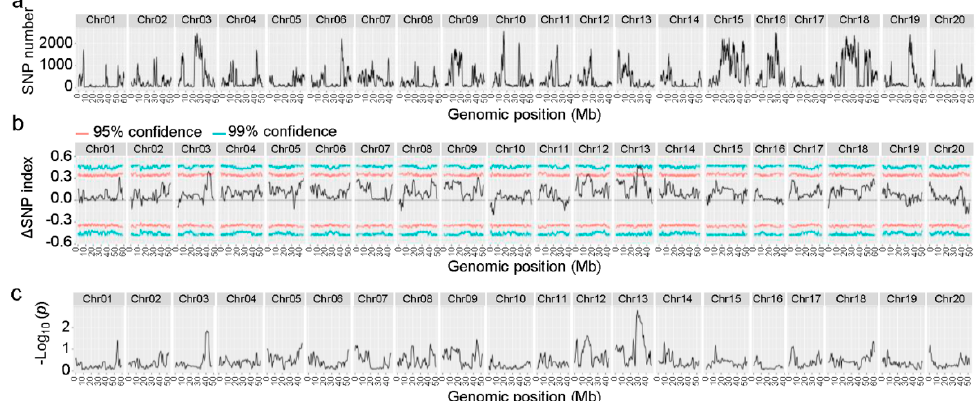
Figure 3. Distribution and plot of SNPs. ( a ) Distribution of all SNPs on twenty soybean chromosomes. ( b ) Δ SNP index graphs from NGS-based BSA. ( c ) Distribution of p value (presented as -log 10 ). X-axis represents the position of twenty chromosomes and Y-axis represents the number of SNPs ( a ), ∆ SNP index ( b ), or p value ( c ). Δ SNP index was calculated in a 1 Mb interval with a 10 kb sliding window. The red and cyan lines indicate expectation values at 95% confidence ( p < 0.05) and 99% confidence ( p < 0.01), respectively, under the null hypothesis.